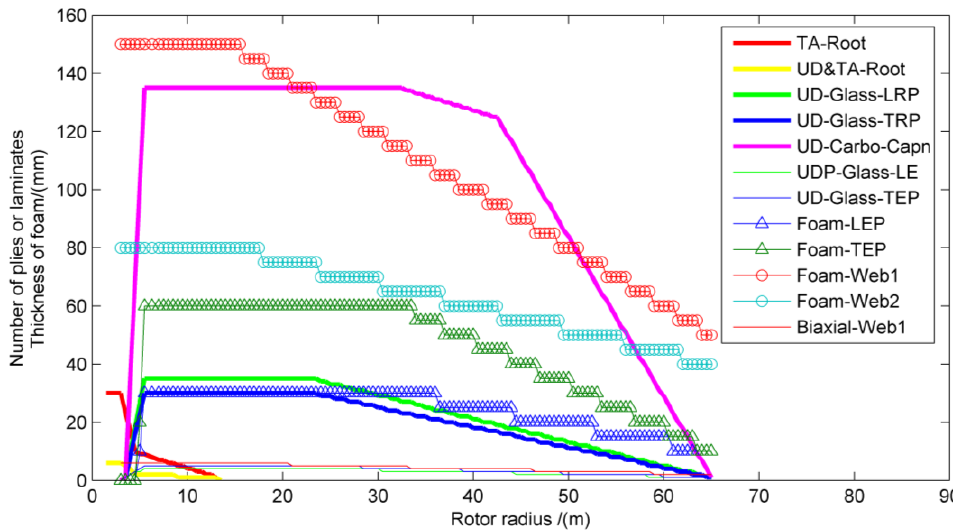
Figure 12. Layup of composite materials of the initial blade.